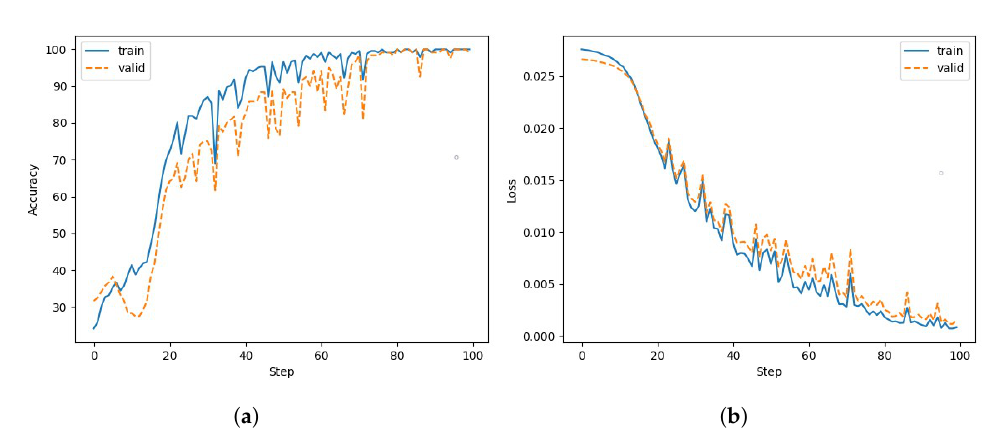
Figure 10. The accuracy and loss curves of IFCNN: ( a ) accuracy curve; ( b ) loss curve.